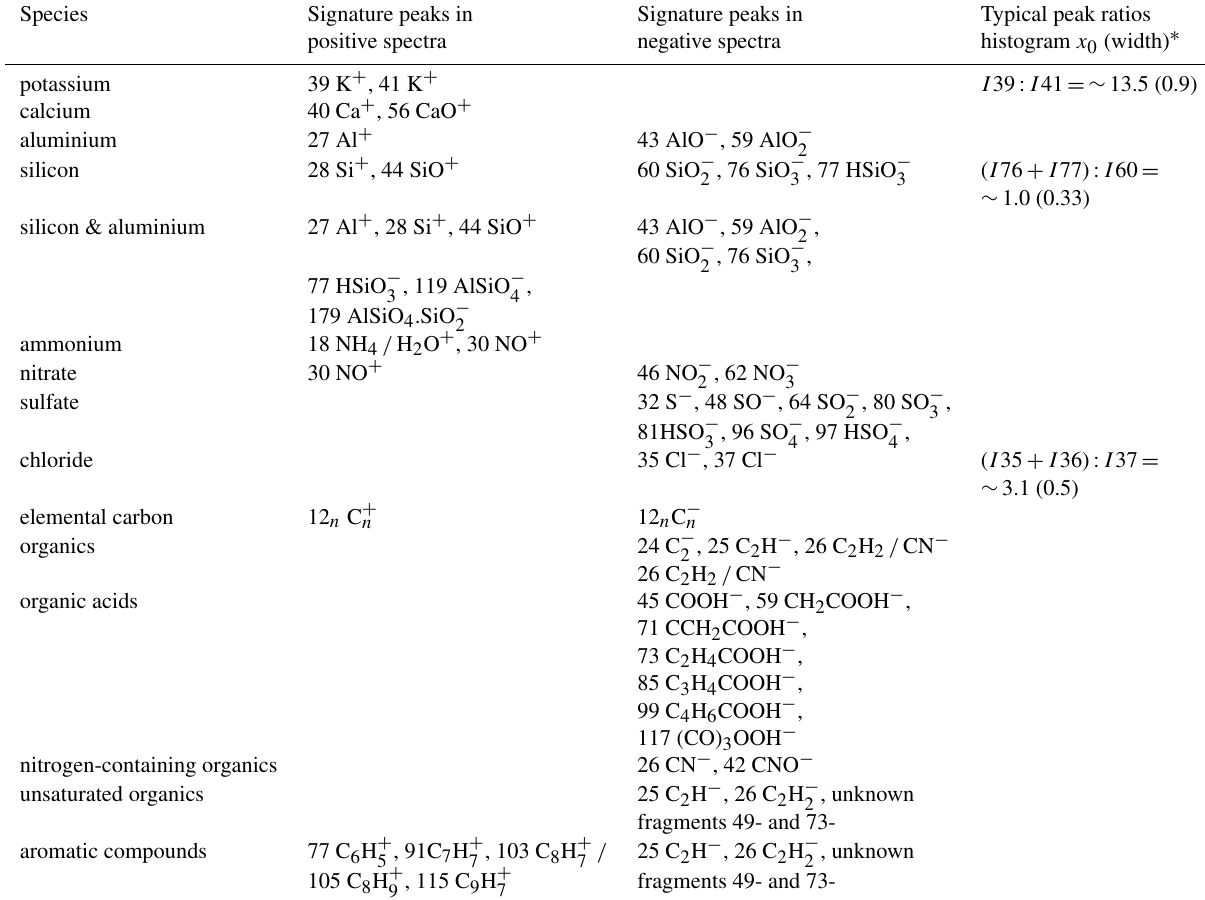
Table 2. Summary of mass spectral